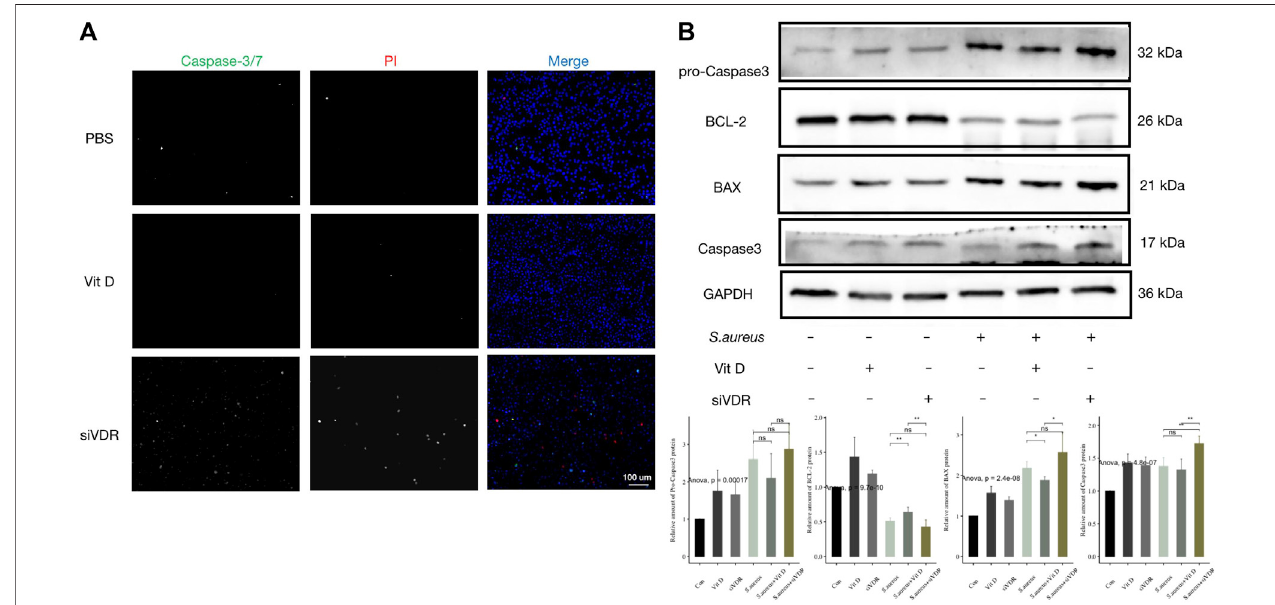
FIGURE 4 | Vitamin D inhibited macrophage apoptosis induced by S. aureus associated infection. (A) Apoptosis detection, Caspase-3/7 (green) and PI (red). Magni fi cation, ×200. (B) Result of western blotting for apoptosis-related proteins. “ ns ” for not signi fi cant, * p < 0.05, ** p < 0.01, and *** p < 0.001.